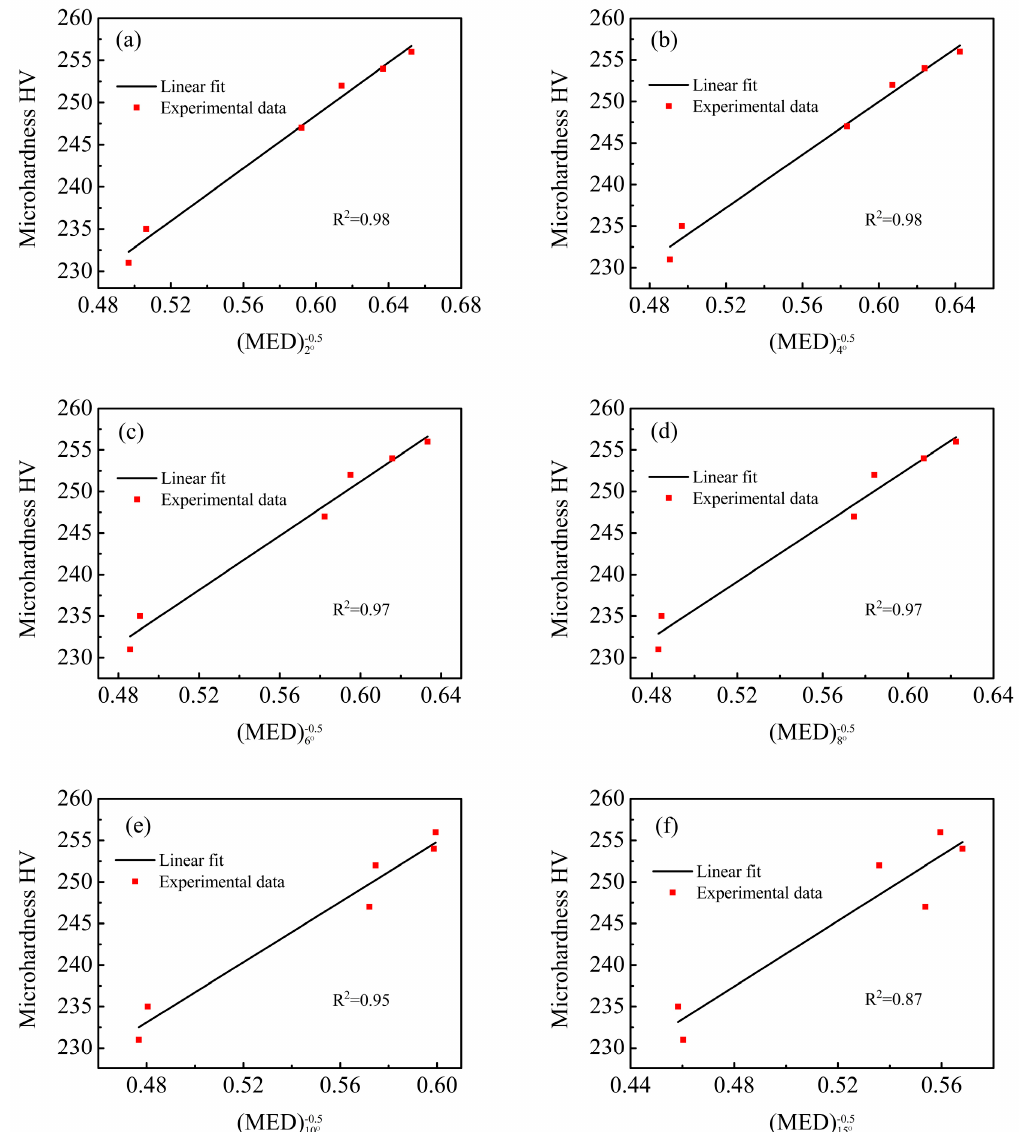
Figure 9. Microhardness of the test steel varied with the reciprocal square root of effective grain size with different tolerance angles: ( a ) 2°; ( b ) 4°; ( c ) 6°; ( d ) 8°; ( e ) 10°; ( f ) 15°.